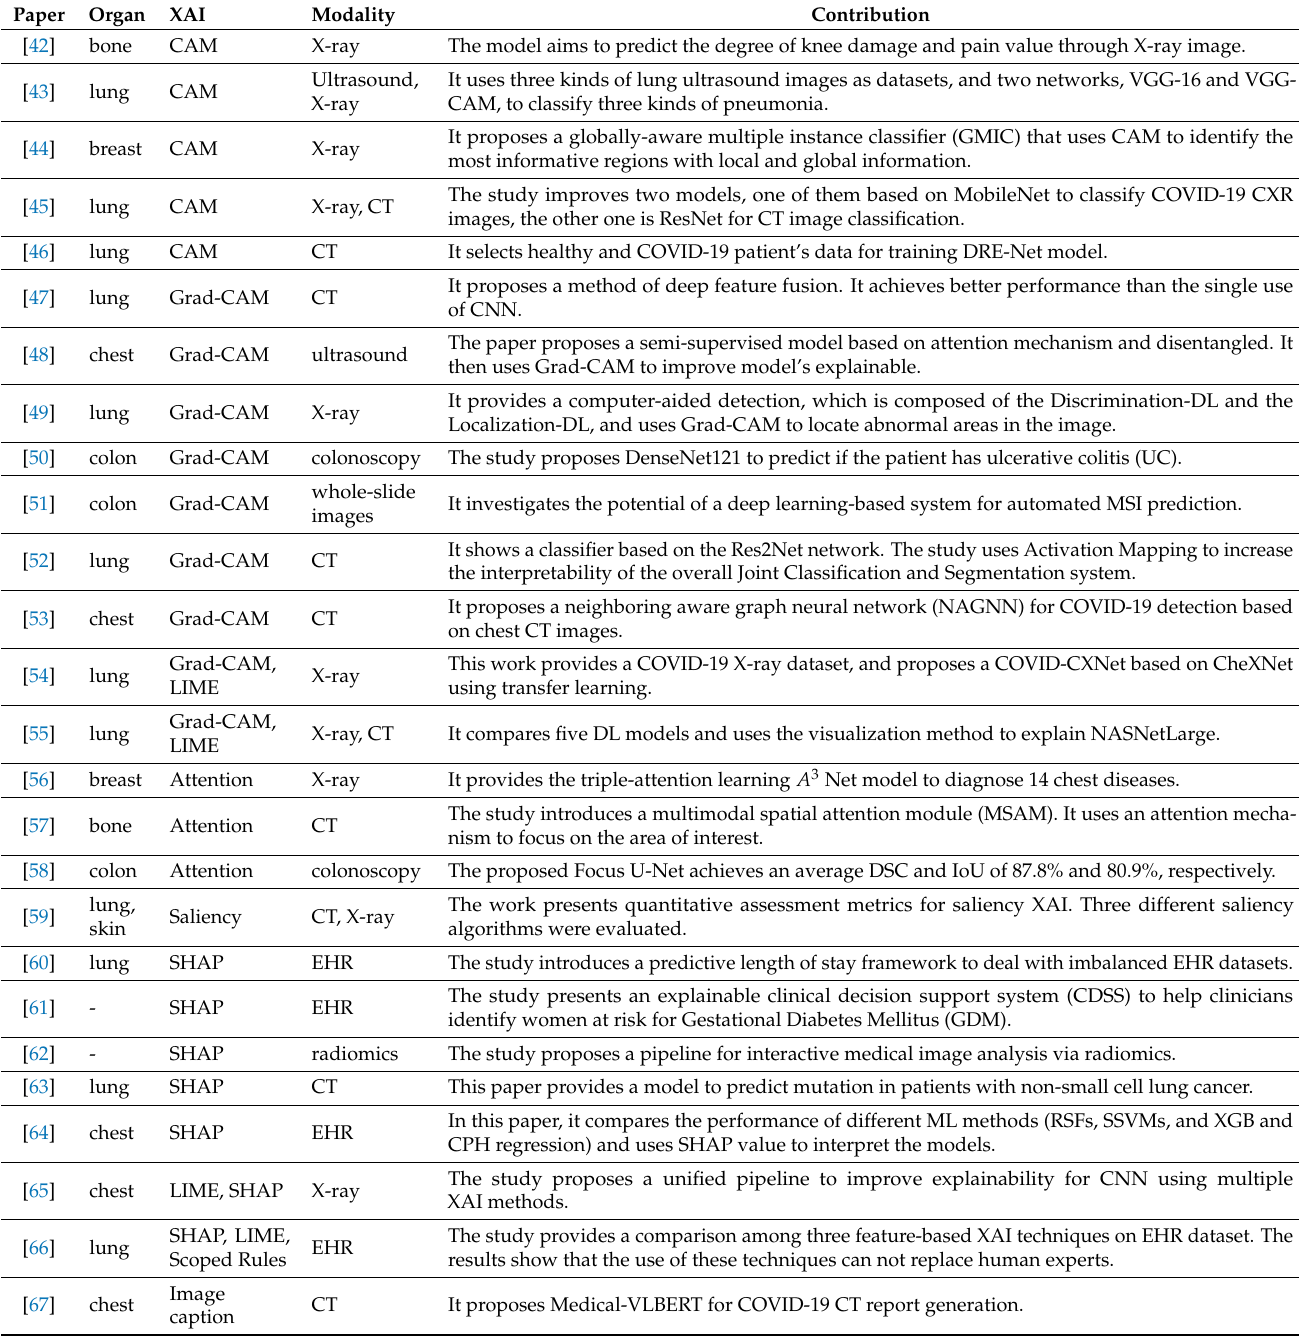
Table 2. The following table is a collection of papers that have used interpretable methods in Section 4 to improve the